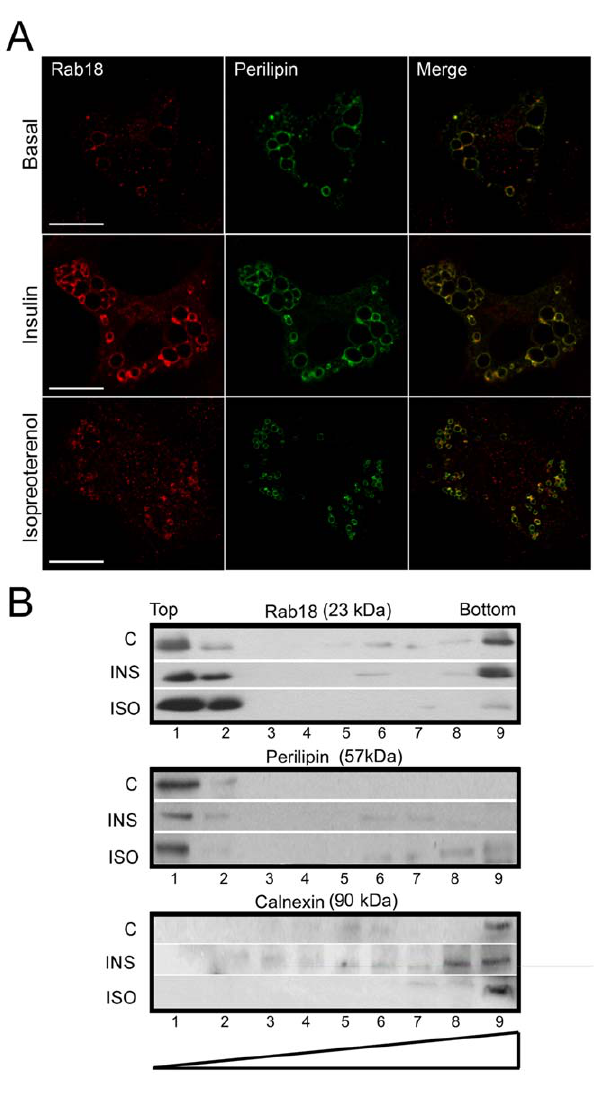
Figure 3. Rab18 subcellular localization in 3T3-L1 adipocytes under insulin or isoproterenol stimulation. (A) Confocal micro- scope images of 3T3-L1 cells under basal conditions (top panels) or challenged with 100 nM insulin (middle panels) or 10 m M isoproterenol (bottom panels) for 4 h and co-immunostained for Rab18 (red) and the LD-associated protein perilipin (green). Colocalization of the two immunosignals can be seen in the most right panels (yellow). Scale bars, 5 m m. (B) Immunoblots of sucrose gradients from 3T3-L1 cells under non-stimulated conditions and after 4-h treatments with 100 nM insulin and 10 m M isoproterenol. Perilipin and calnexin immunoreactiv- ities were used as markers of LD-enriched fractions (light fractions) and microsomal fractions (heavy fractions), respectively. One representative experiment out of three with similar results is shown.